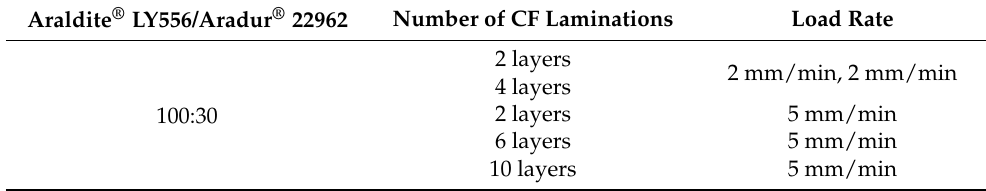
Table 2. Experimental protocol.